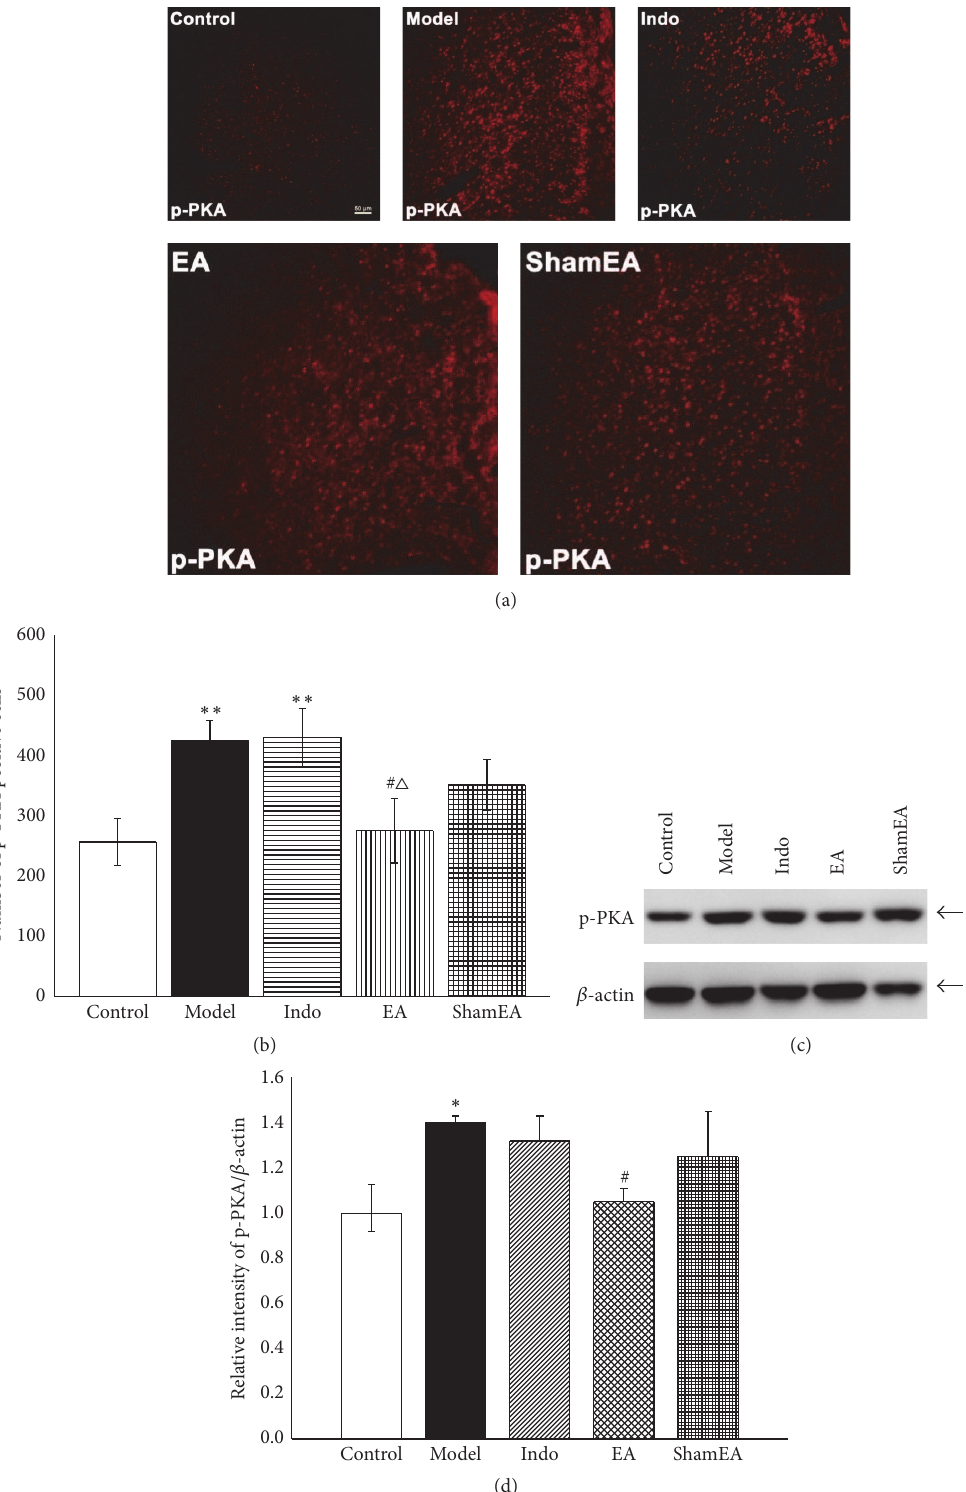
Figure 6: EA decreased the phosphorylation of PKA in the ACC of pain memory model rats. The right ACC tissues of different groups were prepared and labeled with immunofluorescence ( 𝑛 = 3 , five slides for each rat). Total protein extracts from the ACC tissues were detected by western blotting ( 𝑛 = 6 ). (a) Views of p-PKA-positive cells in the ACC (scale bar, 50 𝜇 m). (b) Quantification of p-PKA-positive cells showed that EA treatment at the first injection time point significantly reduced the amount of positive p-PKA. (c) Western blotting analysis of p-PKA in the different groups. (d) Quantitative analysis using the western blot assay showed that EA significantly reduced the phosphorylation levels of PKA. Error bars indicated SEM. ∗ 𝑝 < 0.05 and ∗∗ 𝑝 < 0.01 , versus the control group; # 𝑝 < 0.05 , versus the model group; △ 𝑝 < 0.05 , versus the indo